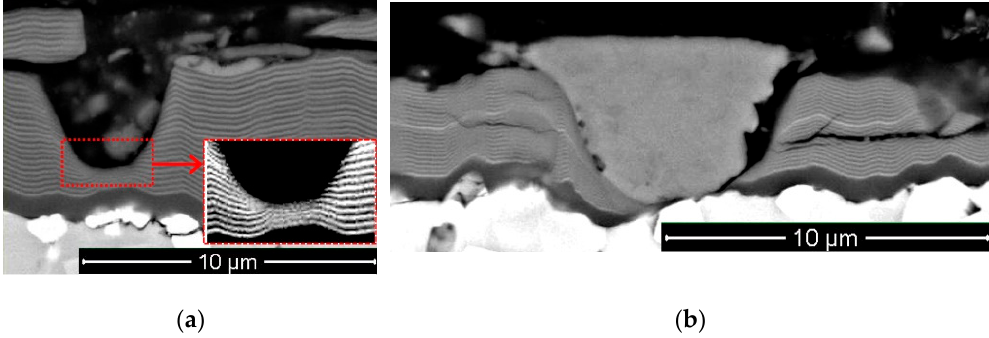
Figure 4. Examples of the influence of microdroplets on the structure of ( a ) Ti–TiN–(Ti,Cr,Mo,Al)N and ( b ) Ti–TiN–(Ti,Nb,Zr,Al)N coatings (SEM 1).